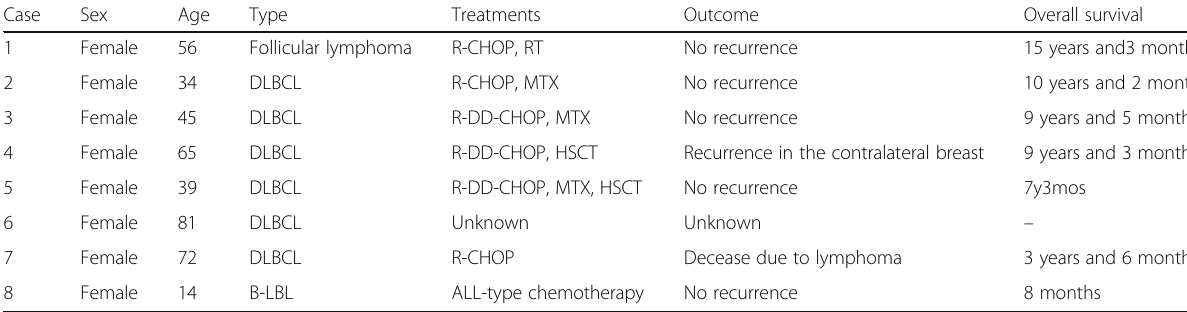
Table 1 Eight cases of PBL diagnosed at our department (2004 – 2019)